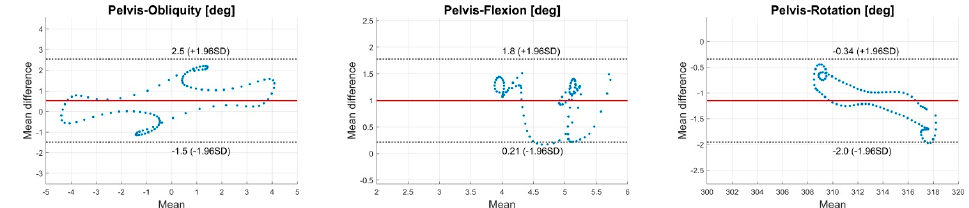
Figure A6. BA diagrams of 3D joint rotations of hip, knee, and ankle of the right side for condition 2. The solid line indicates the mean difference. The dashed lines indicate the LoA (95% CI) of the mean difference.